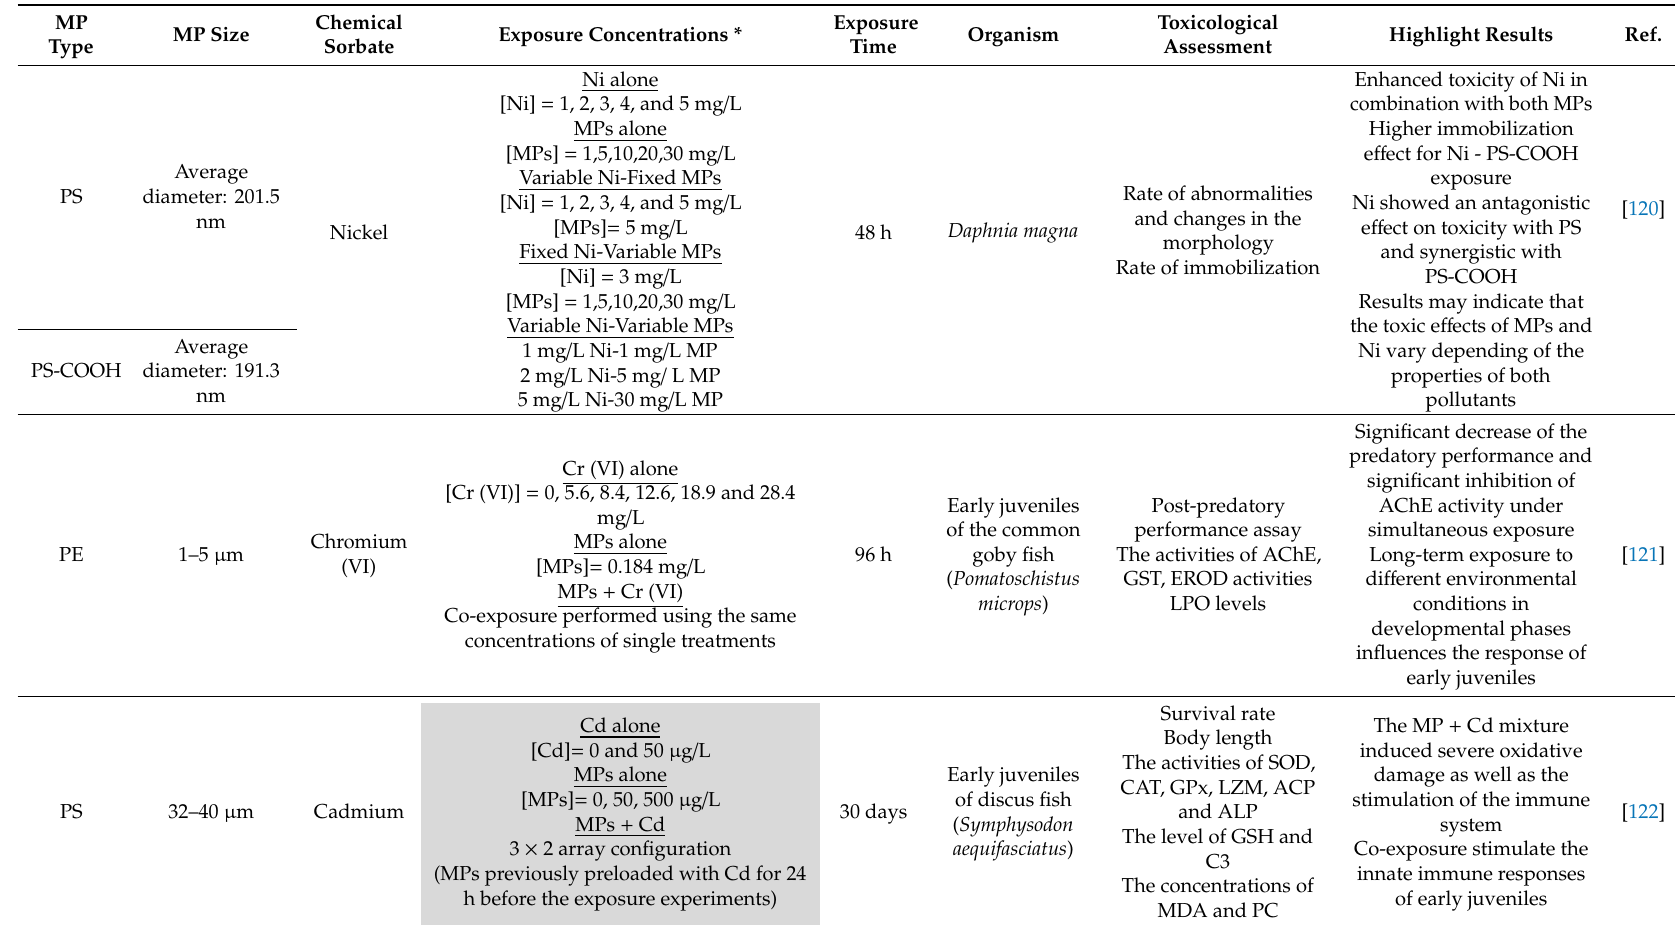
Table 1. Studies assessing the synergetic / antagonistic e ff ect of inorganic pollutants combined with